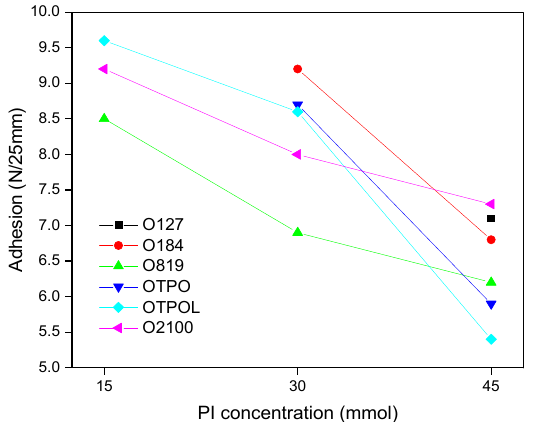
Figure 7. Adhesion to steel of PSA based on BAA cotelomers prepared using different types and concentrations of PIs.